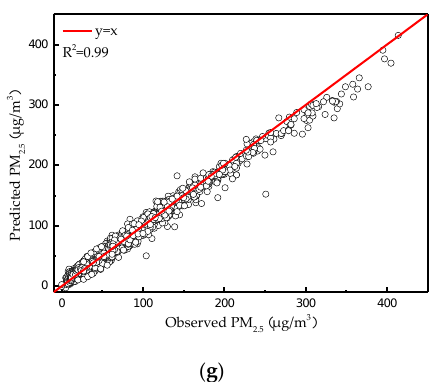
Figure A5. The goodness-of-fit plots for all models in the one-hour PM 2.5 prediction: ( a ) SVR; ( b ) RFR; ( c ) MLP; ( d ) simple RNN; ( e ) LSTM; ( f ) CNN–LSTM; ( g ) AC-LSTM.